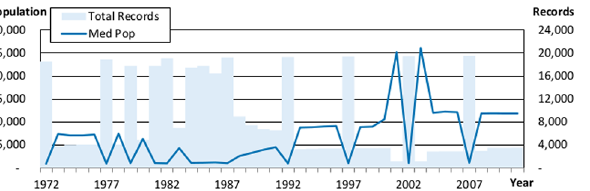
Fig 4. The Relationship between Sample Size and Population for Municipalities. This figure shows how the median population reported in the data for municipalities correlates with the number of total records found in the data for municipalities. Median population is graphed against the left hand axis and the number of records is graphed against the right hand axis.